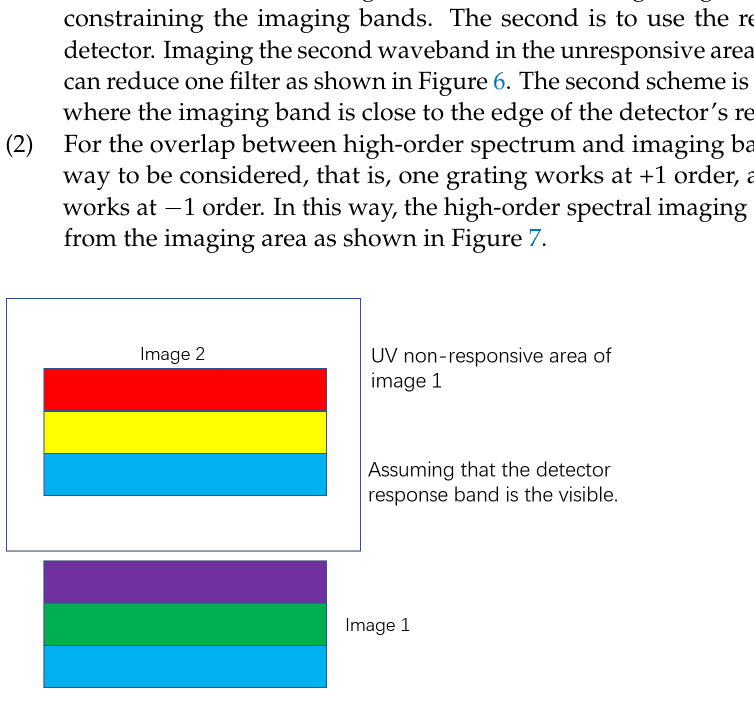
Figure 6. Image 2 is imaged in the unresponsive area in the ultraviolet band of Image 1, which can reduce one